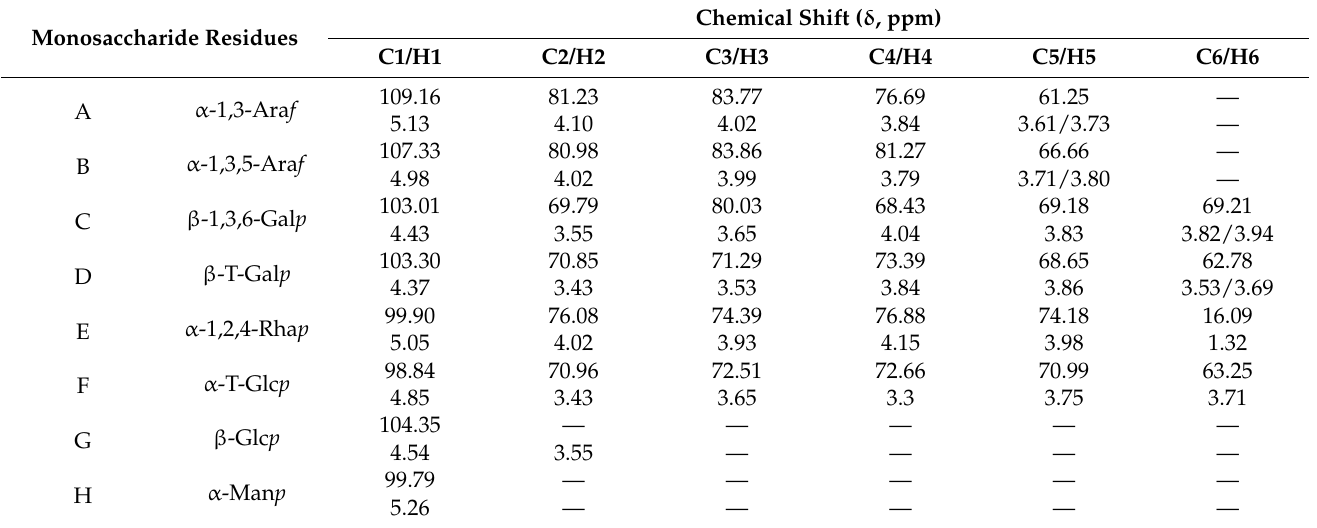
Table 5. The 1 H and 13 C chemical shifts of SSP1 backbone.